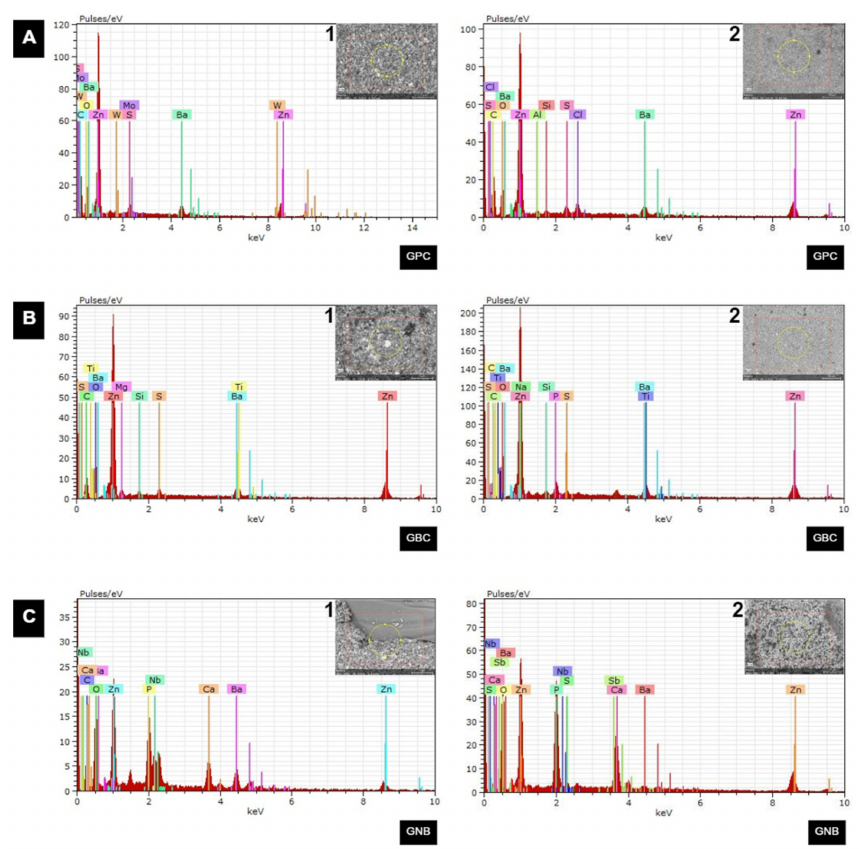
Figure 5. Representative EDS analysis images of the samples in all of the evaluated groups. ( A ) GPC group. Presence of elements such as Ba (barium) and Zn (zinc), W (tungsten), S (sulfur), MO (molybdenum), C (carbon), and O (oxygen) before (1) immersion in SBF. Presence of Zn, Ba, S, C, SI (silicon), and AL (aluminum) appeared after 28-days of immersion (2) in SBF. ( B ) GBC group. Presence of elements such as Ba, Zn, NB (niobium), P (phosphorus), O, CA (calcium), C, and S before (1) immersion in SBF. Presence of Ba, Zn, P, O, C, S, NA (sodium), and TI (titanium) appeared after 28 days of immersion (2) in SBF. ( C ) GNB group. Presence of elements such as Nb, Ca, P, C, Ba, Zn, and O before (1) immersion in SBF. Presence of Nb, Ca, P, C, Ba, Zn, O, SB (antimony), and S appeared after 28 days (2) of immersion in SBF, and there was a substantial increase in the intensity of the Ca and P peaks, attributed to the formation of precipitates on the surface of the material.